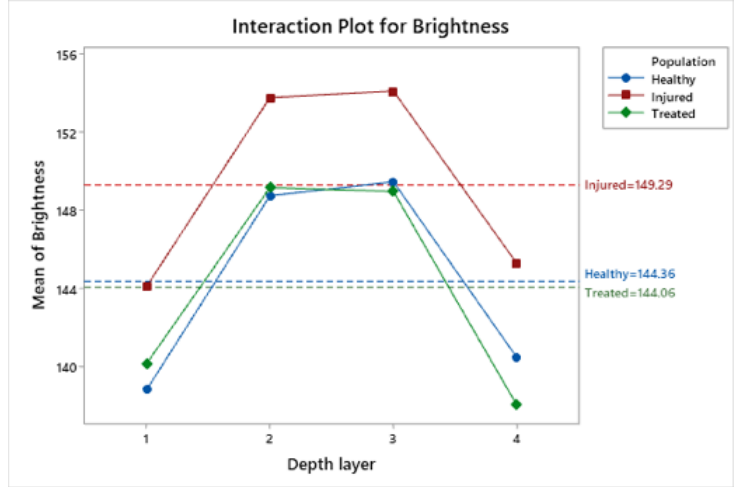
Table 1. Sample mean, median, and variance-related statistics by corneal population (St.Dev: standard deviation; CV: coefficient of variation; IQR: interquartile range).